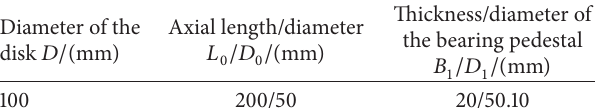
Table 1: Basic parameters of the journal bearing rotor system.